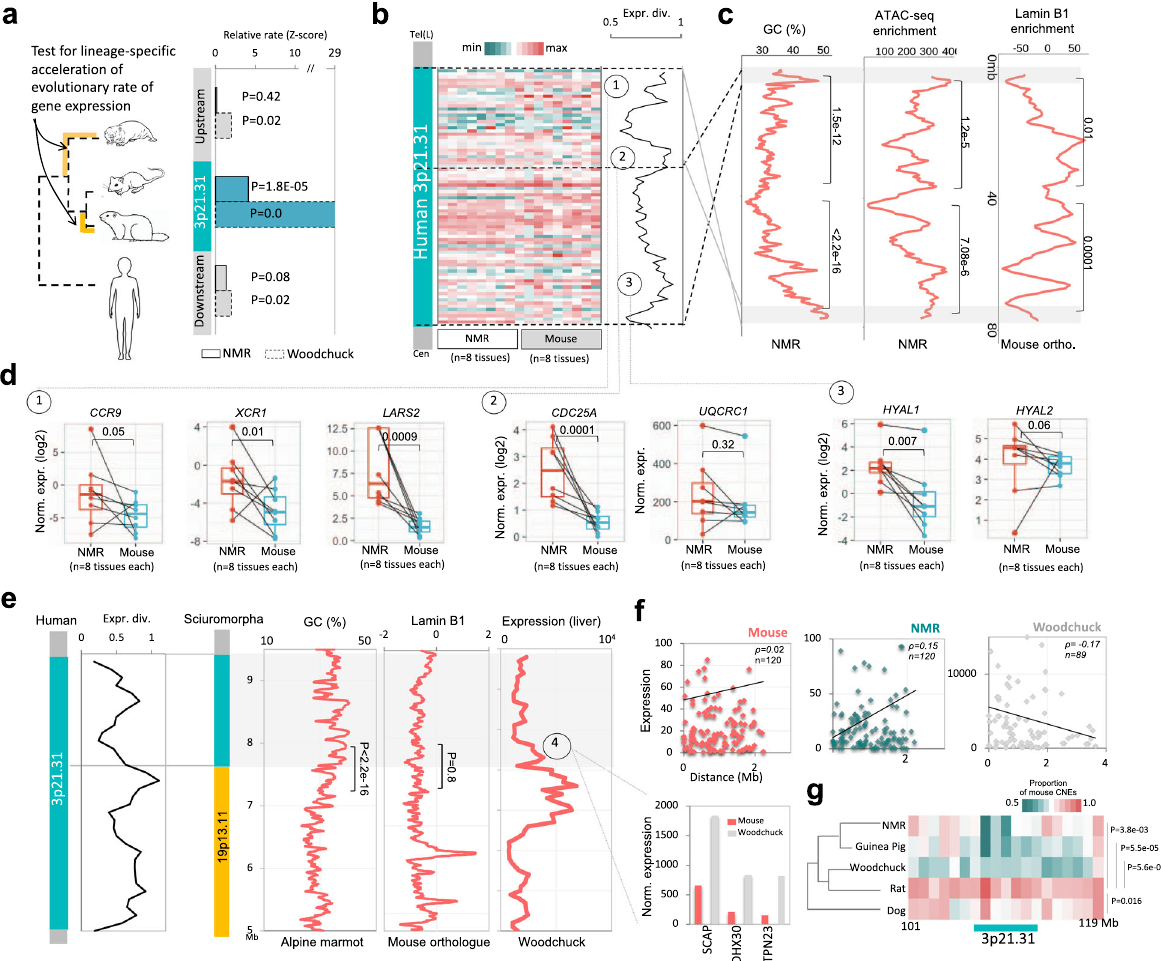
Fig. 5 Hystrico- and sciuromorph-speci fi c relaxation of functional constraints on 3p21.31. a Rate of gene expression evolution in NMR and woodchuck, considering mouse as control and human as an outgroup. Expression rates are presented as Z score and the P values are from Z test. b Heatmap: quantile-normalised expression data of 3p21.31 genes in the skin, thymus, ovary, kidney, adrenal, heart, testes and liver (in that order) of mouse and of NMR. Line plot: mouse-to-NMR expression divergence of genes. c GC content, chromatin accessibility (ATAC-seq enrichment in NMR skin fi broblasts), and ChIP-Seq LaminB1 enrichment (mouse fi broblasts) along NMR scaffold JH602043.1. P values were calculated using two-sided Mann – Whitney U tests. Effect sizes: 0.54 and 0.73 for GC content; 0.17 and 0.17 for ATAC-seq; 0.073 and 0.18 for LaminB1 enrichment. d Quantile-normalised gene expression values of genes (for the same tissues as in b ) located towards the breakpoint regions that are highlighted in the line plot of 3p21.31 expression divergence. The matching tissues of the mouse and NMR are marked by connecting lines between paired boxes. P values were calculated using two-sided Mann – Whitney U tests. Boxplot annotation: centre line, median; box limits, upper and lower quartiles; whiskers, 1.5× interquartile range; points, outliers. Effect sizes: 0.19, 0.28, 0.70, 0.70, 0.06, 0.39, and 0.15 from left to right. A comparison of normalised expression values of mouse and woodchuck genes near the breakpoint region-4 is shown in the barplot. e Left panel: gene-wise expression divergence between mouse and woodchuck along 3p21.31 locus. Right panel: GC content (Alpine marmot), LaminB1 enrichment (in mouse orthologous regions), and gene expression (woodchuck liver) across the rearranged locus involving part of 3p21.31 and 19p13.11 loci. P values were calculated using two-sided Mann – Whitney U tests. Effect sizes: 0.54 for GC content, 7.9e-6 for LaminB1 enrichment. f Expression of 3p21.31 genes in mouse, NMR and woodchuck as a function of distance from the nearest breakpoint. Mean expression levels across tissues were plotted. Effect sizes: Pearson ’ s correlation coef fi cient ( ρ ) are mentioned in the plots. g Proportion of mouse-conserved mammalian CNEs present in NMR, woodchuck, guinea pig, rat and dog. P values were calculated using two-tailed t tests between rat and other species. Effect sizes: 1.91, 3.24, 5.12, 1.65 for NMR – rat, GP – rat, Woodchuck – rat and dog – rat comparisons